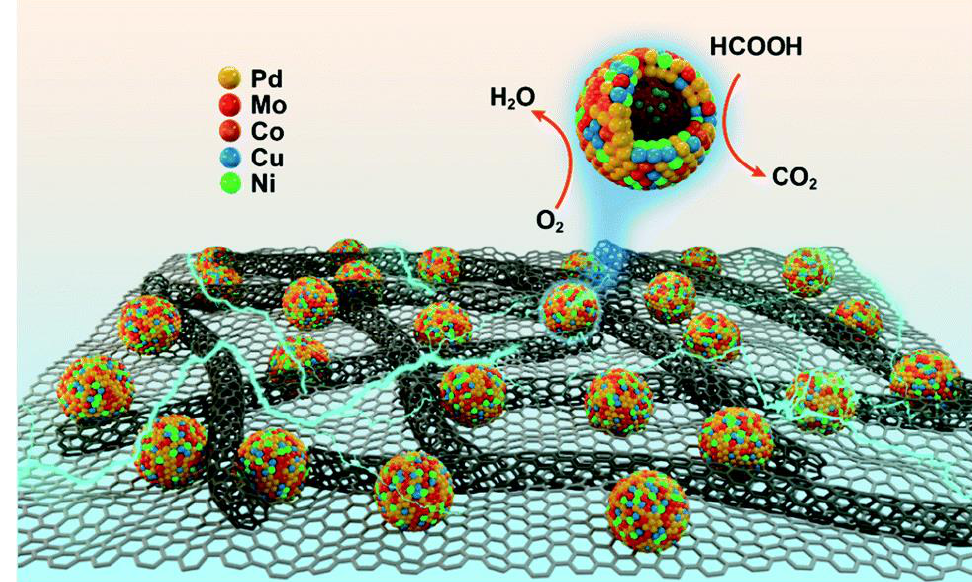
Figure 19. A schematic representation of the work of the catalyst in catalytic FAO and ORR. (Reprinted with permission from [275]. Copyright 2022, Royal Society of Chemistry).